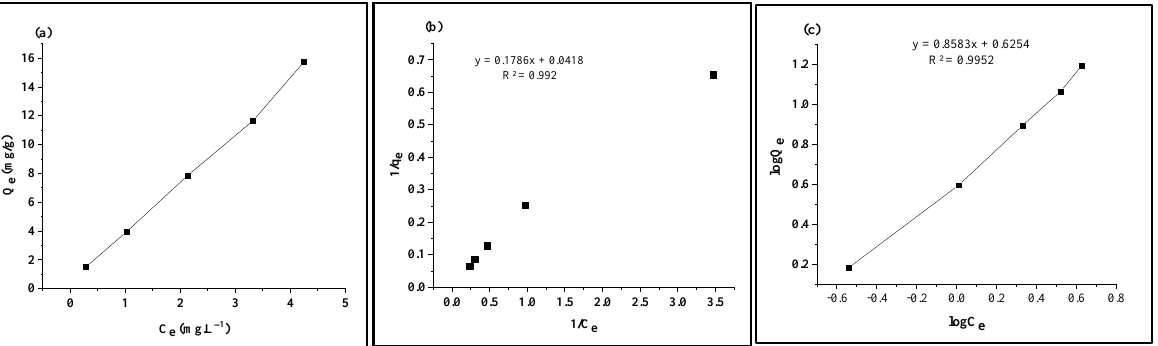
Figure 3. ( a ) Plot of Q e vs. C e ( b ) Langmuir ( c ) Freundlich adsorption isotherm of fluoride using 0.5 Fe-Si-5.